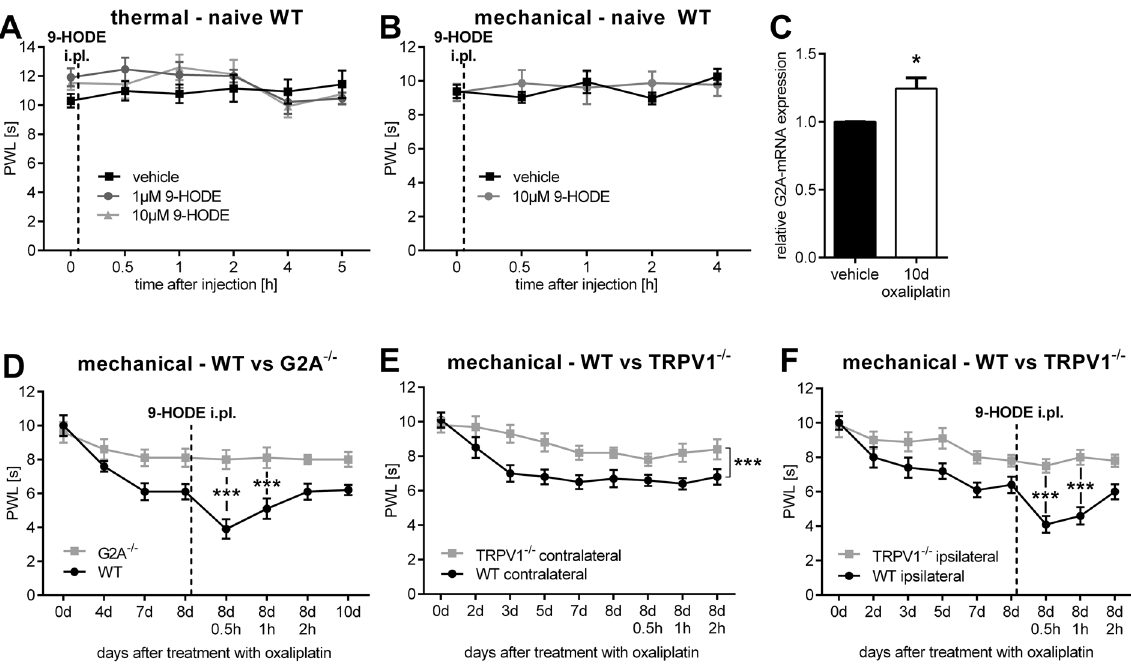
Figure 6. G2A-deficient and TRPV1-deficient mice have reduced 9-HODE-dependent mechanical pain during oxaliplatin treatment. ( A ) Thermal pain thresholds of naive wildtype mice after i.pl. (intraplantar) injection of 9-HODE (1 µ M and 10 µ M) into the left hind paw using a Radiant Heat Test. Shown is the mean ± SEM of PWL of n = 8 mice per group. ( B ) Mechanical pain thresholds of naive wildtype mice after i.pl. (intraplantar) injection of 9-HODE (10 µ M) into the left hind paw using a dynamic plantar aesthesiometer. Shown is the mean ± SEM of PWL of n = 6 mice per group. ( C ) G2A-mRNA expression in DRG of mice treated with oxaliplatin (3 mg/kg) for ten days compared to vehicle treated mice. Data presented as mean ± SEM with n = 4 mice per group; * p < 0.05 unpaired student’s t-test. ( D ) Mechanical pain thresholds of wildtype compared to G2A-deficient mice after treatment with oxaliplatin (3 mg/kg) over eight days. Then 9-HODE (10 µ M) was injected i.pl. into the left hind paw and PWL was measured again after 0.5 h, 1 h and 2 h. Shown is the mean ± SEM of PWL of the 9-HODE treated paw of n = 7 mice per group; *** p < 0.001 two-way ANOVA with Bonferroni post-hoc test. ( E ) Mechanical pain thresholds of wildtype mice (WT) compared to TRPV1-deficient mice after treatment with oxaliplatin (3 mg/kg) using a dynamic plantar aesthesiometer over eight days. Shown is the mean ± SEM of PWL of the contralateral paw (untreated) of n = 7 mice per group; *** p < 0.001 two-way ANOVA. ( F ) Mechanical pain thresholds of wildtype mice compared to TRPV1-deficient mice after treatment with oxaliplatin (3 mg/kg). At day eight, 9-HODE (10 µ M) was injected i.pl. into the ipsilateral paw and PWL was measured again after 0.5 h, 1 h and 2 h. Shown is the mean ± SEM of PWL of the ipsilateral paw (9-HODE treated) of n = 7 mice per group; *** p < 0.001 two-way ANOVA with Bonferroni post-hoc